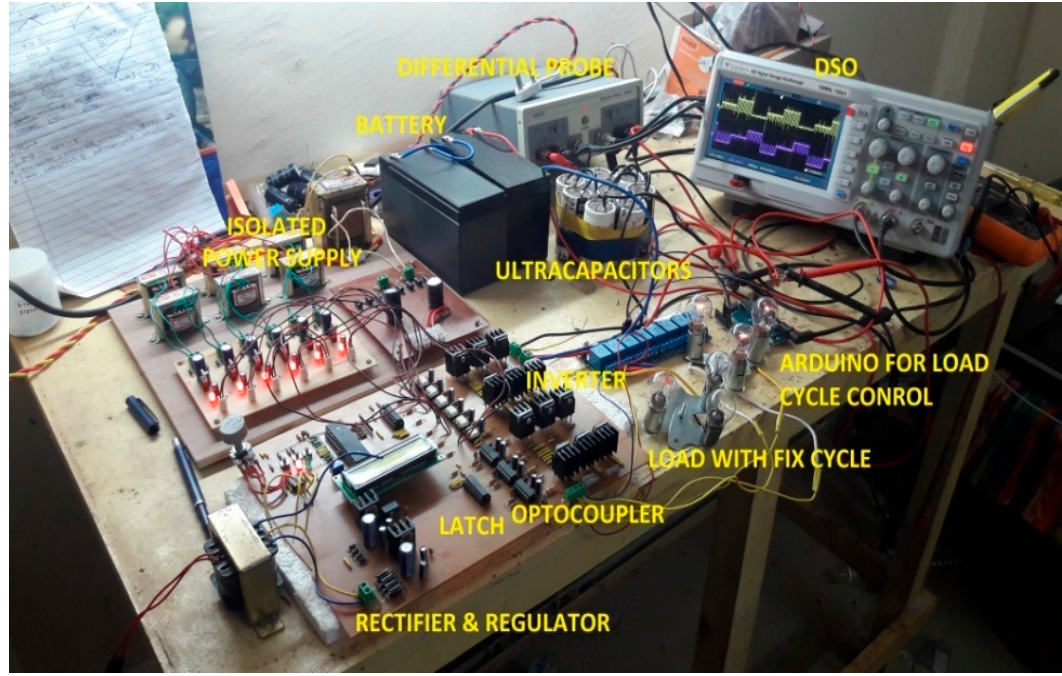
Figure 39. Experimental setup.